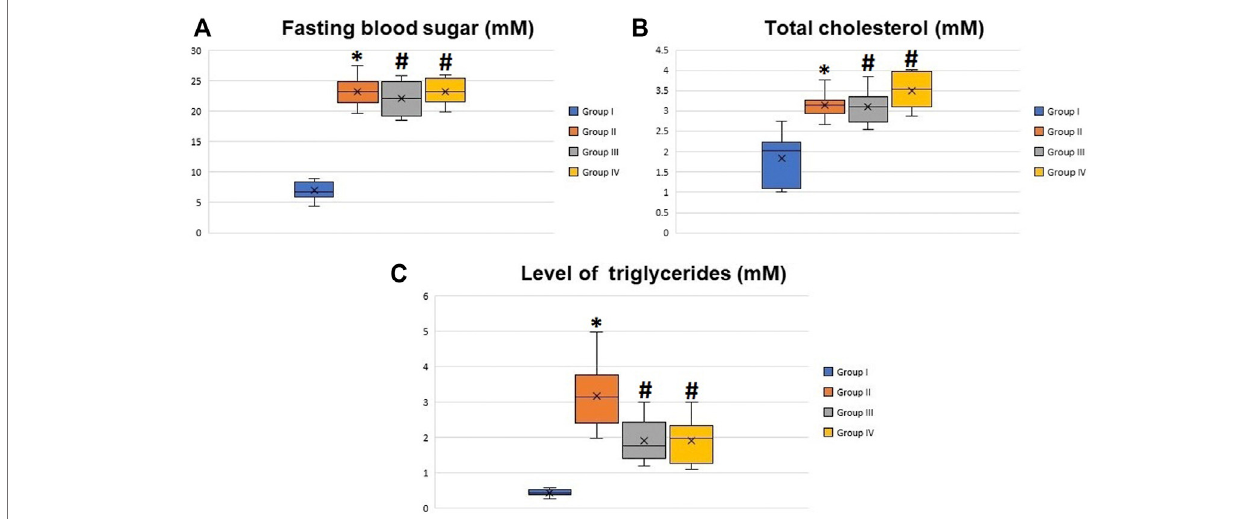
FIGURE 2 | Boxplot graphs showing the mean values of fasting blood glucose (A) , total cholesterol (B) , and triglyceride levels (C) in all groups 8 weeks after the induction of diabetes. All the measured values showed a signi fi cant increase in diabetic rats (groups II, III, and IV) compared to the control group (group I) and non- signi fi cant difference between groups II, III, and IV. *Signi fi cant difference compared to group I ( p < 0.05). #Signi fi cant difference compared to group II ( p < 0.05).